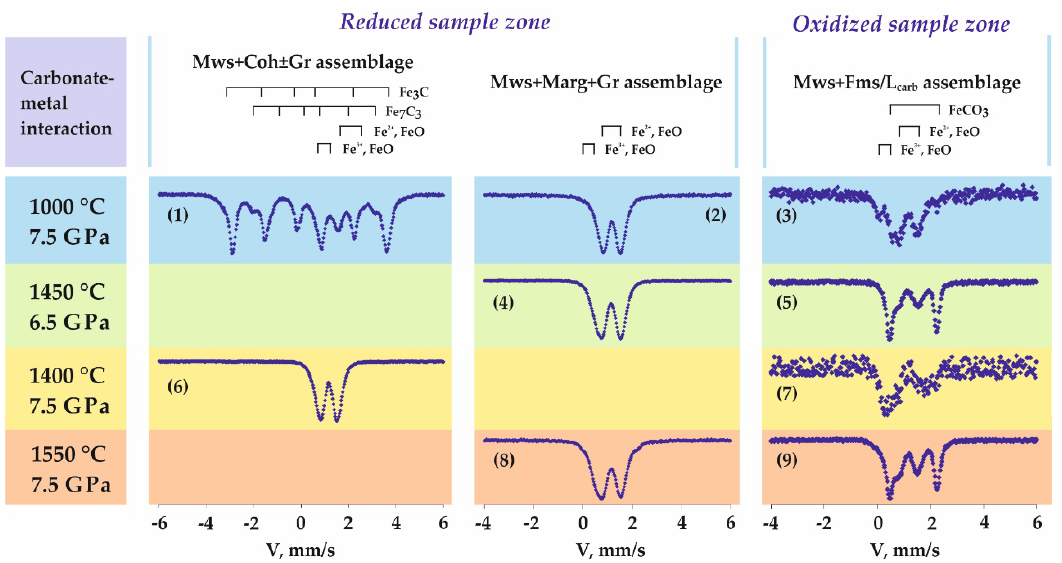
Figure 4. Mössbauer spectra of samples from reduced (1,2,4,6,8) and oxidized (3,5,7,9) zones, which were produced in experiments in the carbonate-iron system. (a) and (b) – assemblages of reduced sample zones, (c) – assemblages of oxidized sample zone.